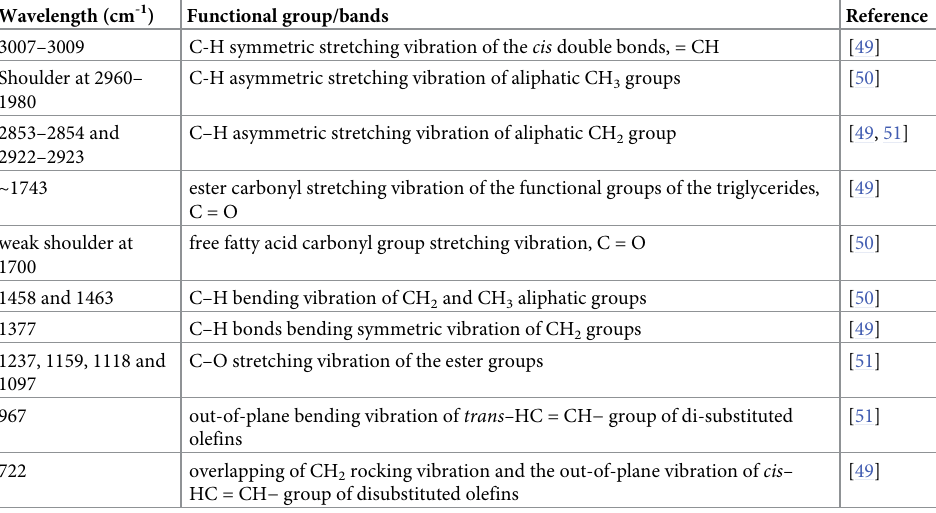
Table 3. The main functional groups observed on the studied oils by FTIR spectroscopy and their corresponding